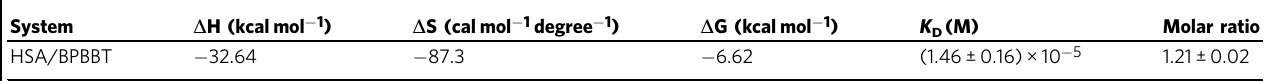
Table 1 Thermodynamic parameters of HSA/BPBBT interaction obtained from ITC measurements System